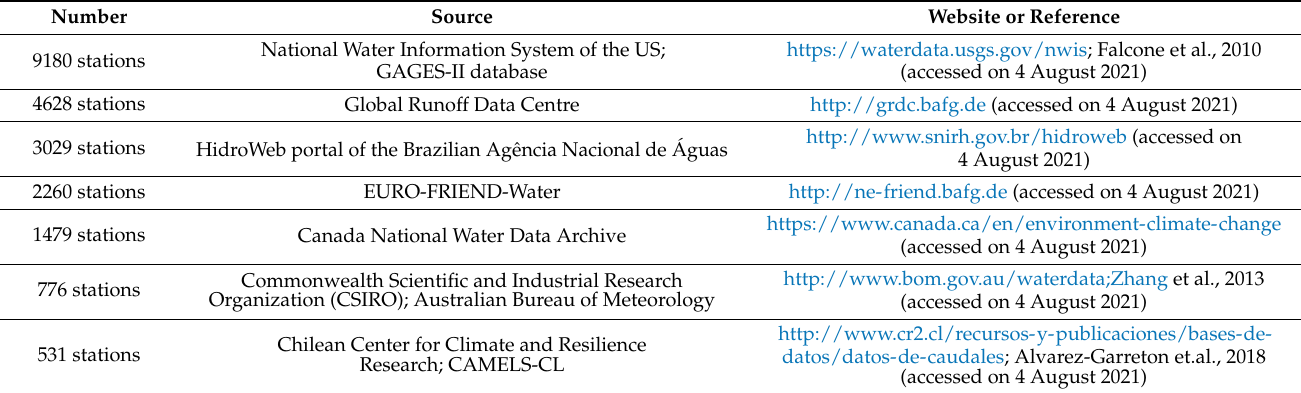
Table 2. Summary of station observations’